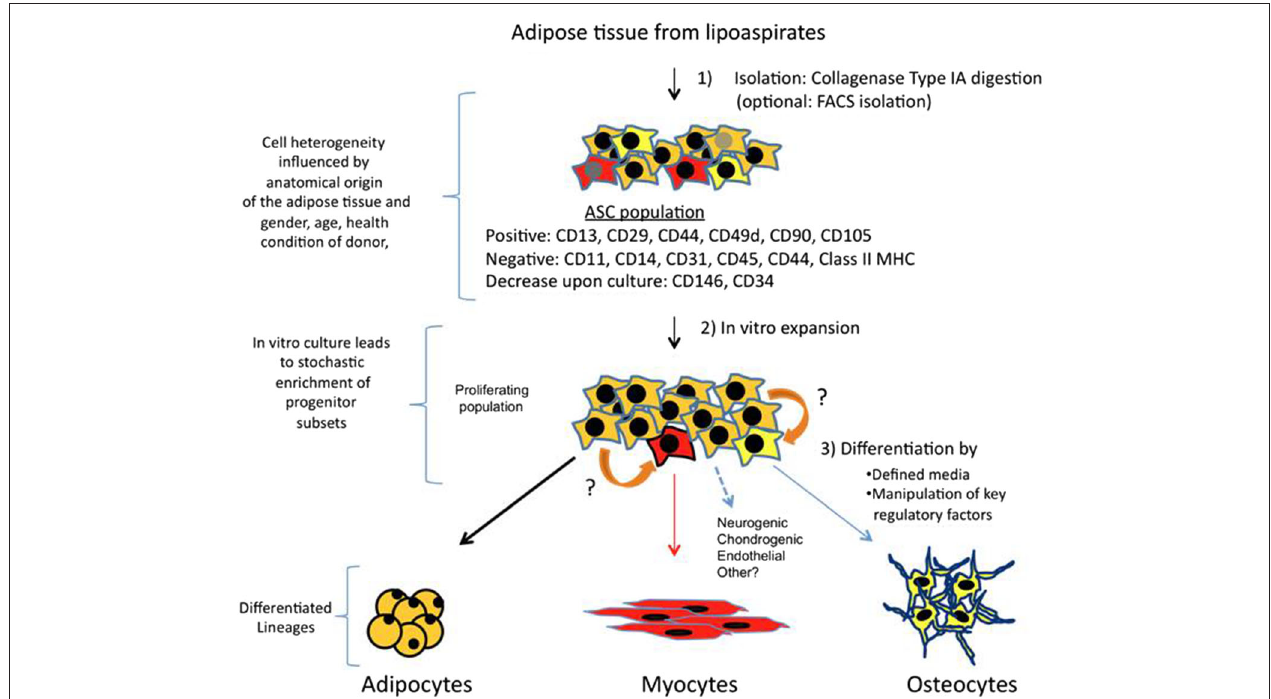
population, which can arrive to 70 PDs, can also alter percentages of specific progenitors. Therefore, differential expression of CD markers and their fluctuations may represent a heterogenic composition of ASCs, which contain subsets of multipotent cells that can respond to differentiation cues of other lineages (represented in red and yellow). Adipocyte is the main lineage obtained from ASCs, however, upon culture with defined media, or by ectopically expressing specific factors, myogenic, osteogenic and other lineages can also be obtained. It is also possible that progenitors can transdifferentiate (indicated by orange arrows) in response to lineage specific